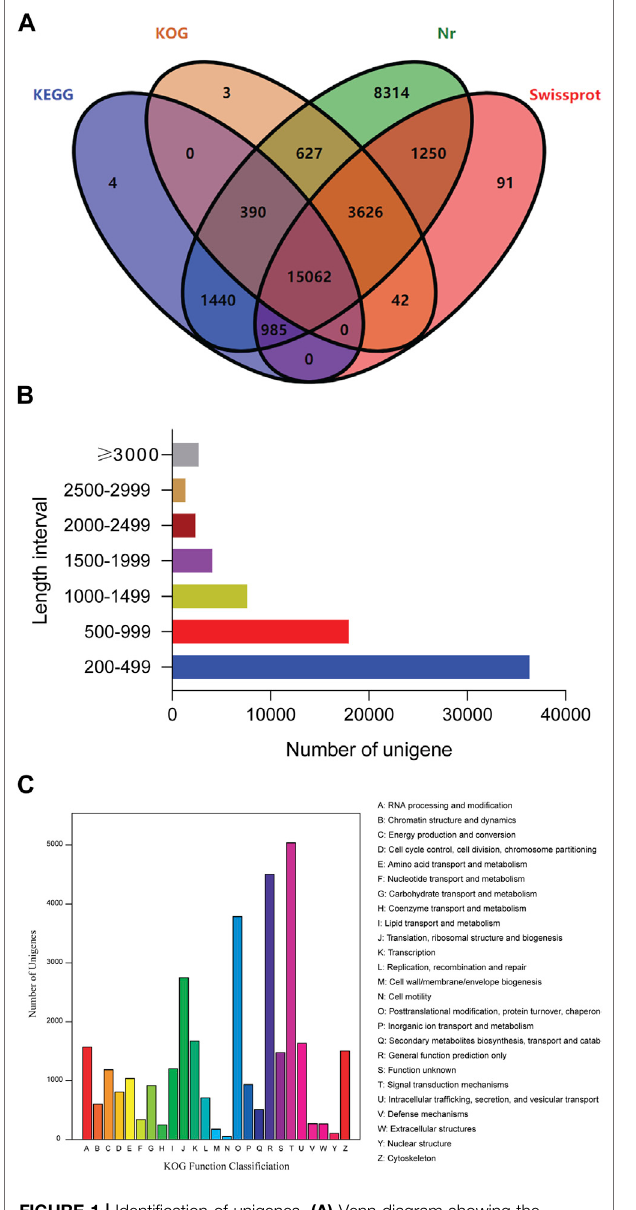
FIGURE 1 | Identi fi cation of unigenes. (A) Venn diagram showing the commonanduniqueunigenesbyfourmethods,includingtheKEGG,KOG,Nr and Swiss-protein databases. (B) Number of unigenes with different lengths. (C) Distribution of unigenes based on functional classi fi cation.